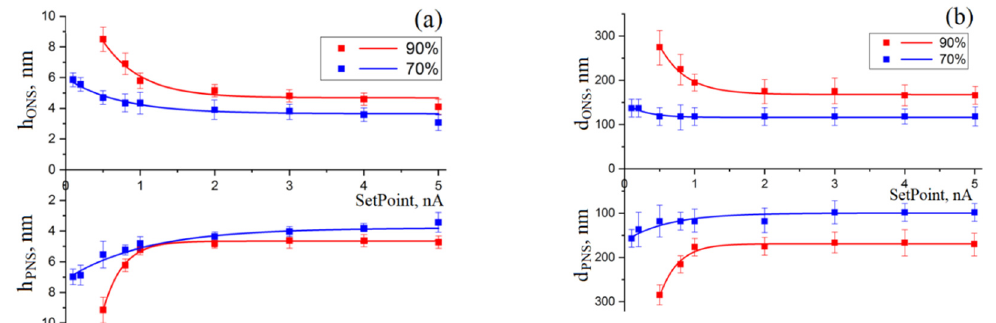
Figure 2. Dependences of the geometric parameters of nanostructures on the cantilever oscillation amplitude and the SetPoint parameter for the LAO surface of GaAs. The amplitude of the applied voltage is 15 V, the feedback circuit current is 2 nA, the air humidity is 1—90 ± 1% and 2—70 ± 1%: ( a )—the height of the ONS and the depth of the PNS; ( b )—the diameter of the ONS and PNS. Additionally, an increase in SetPoint from 0.5 to 5 nA at a relative humidity of 90% leads to a decrease in the ONS height from 8.5 ± 0.8 to 4.1 ± 0.5 nm, in the PNS depth from 9.1 ± 0.8 nm to 4.2